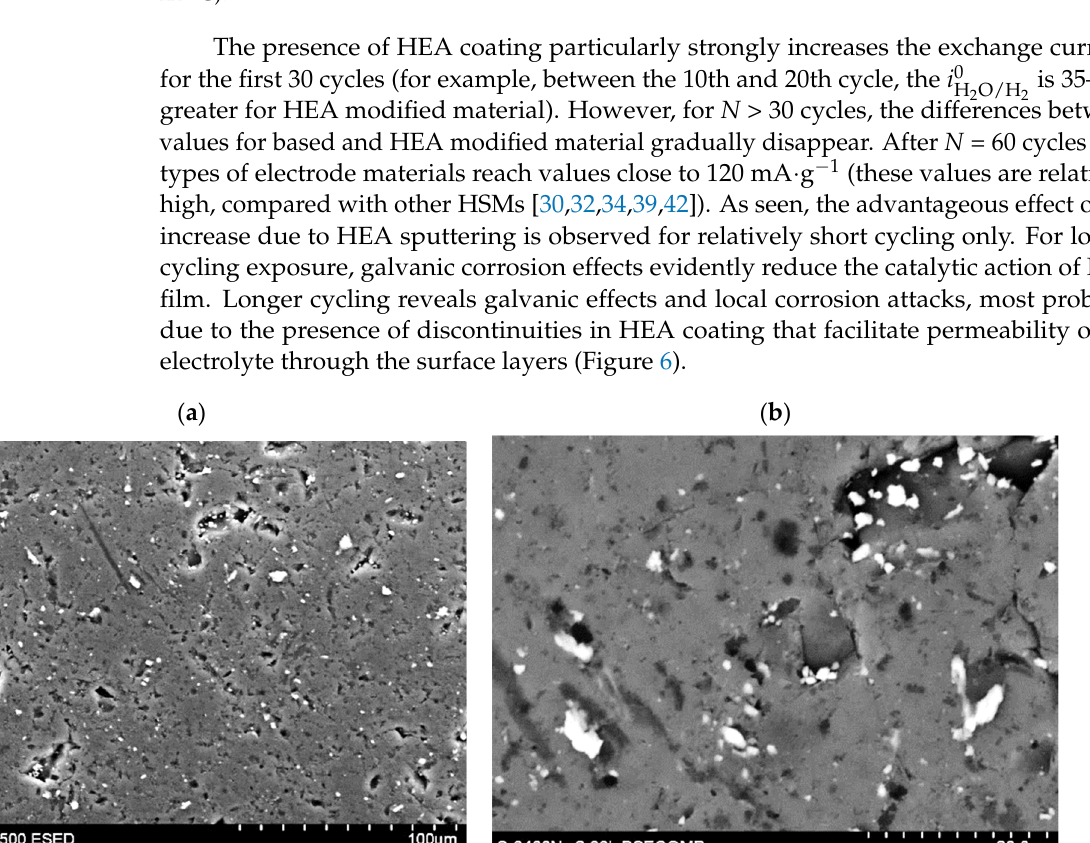
Figure 5. Exchange current density of H 2 O/H 2 system as a function of cycle number for electrodes made of based LaNi 4.5 Co 0.5 HSM material and HSM modified with HEA coating (6M KOH, Ar, 22 °C).